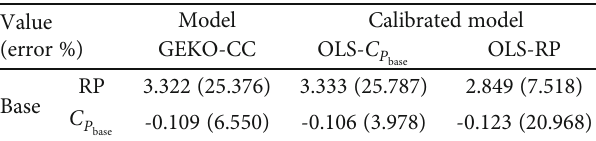
Table 12: Value and error of QoIs corresponding to each calibrated model (axisymmetric